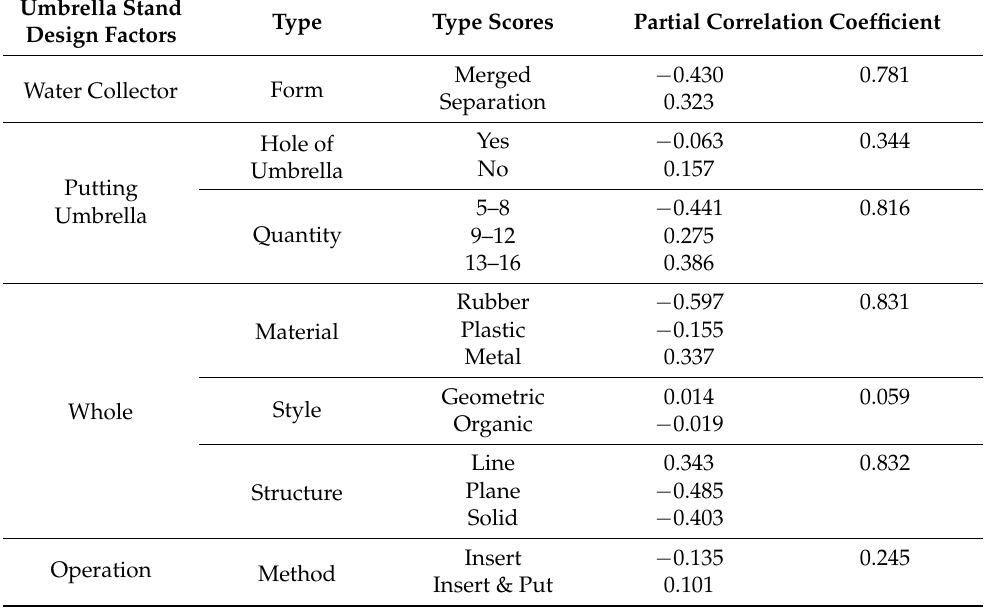
Table 4. Partial correlation coefficient of UD